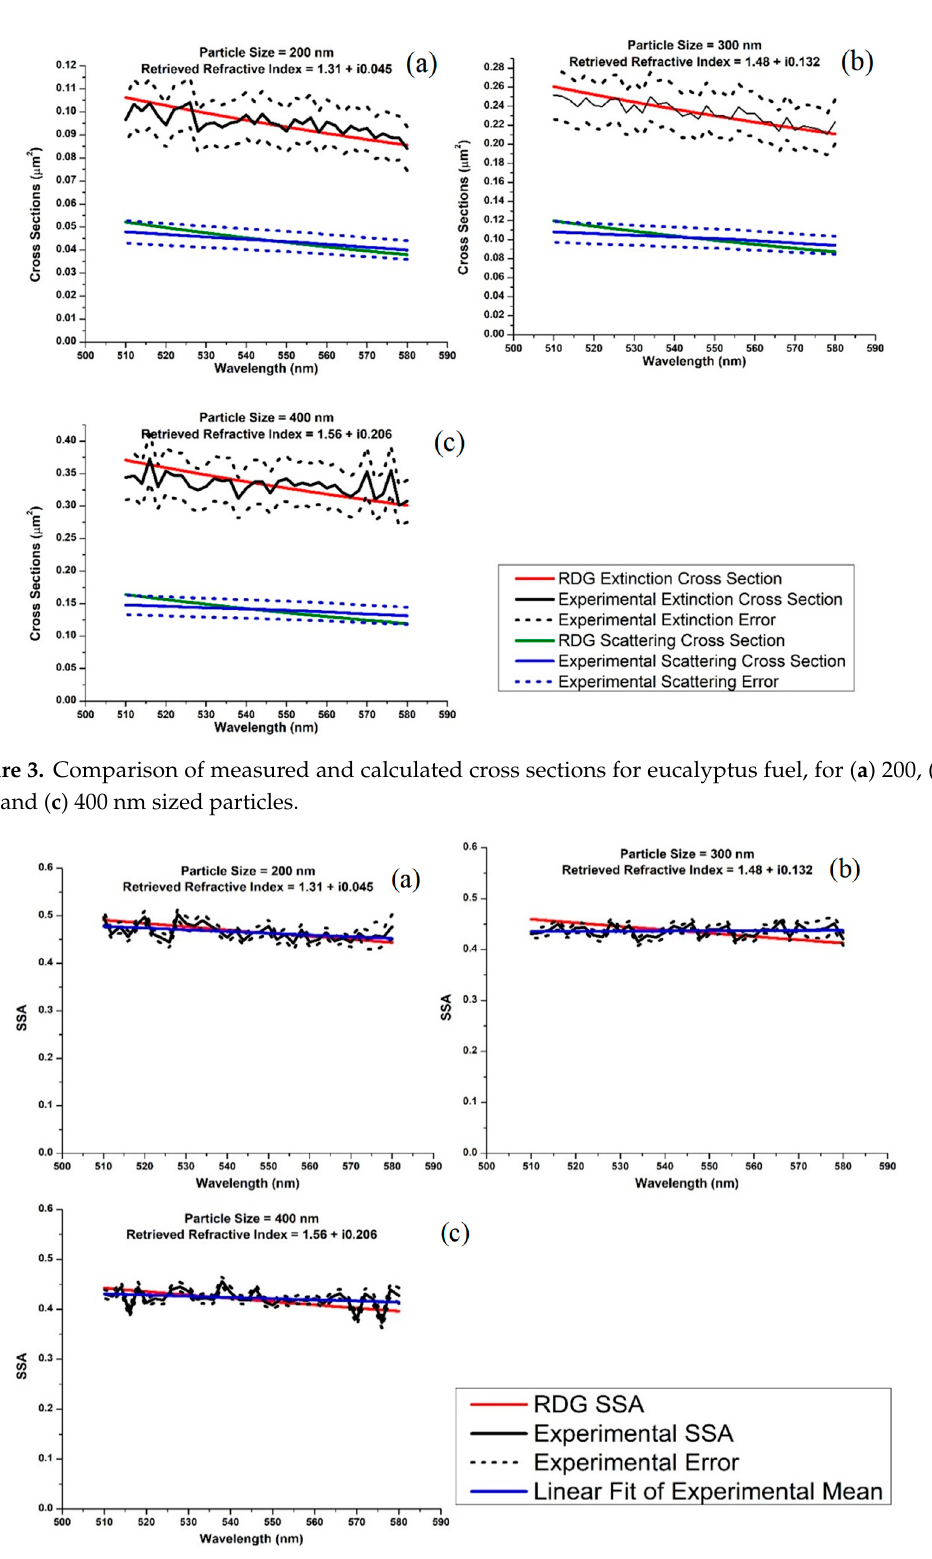
Figure 4. Comparison of measured and calculated SSA values for eucalyptus fuel, for ( a ) 200, ( b ) 300, and ( c ) 400 nm sized particles.